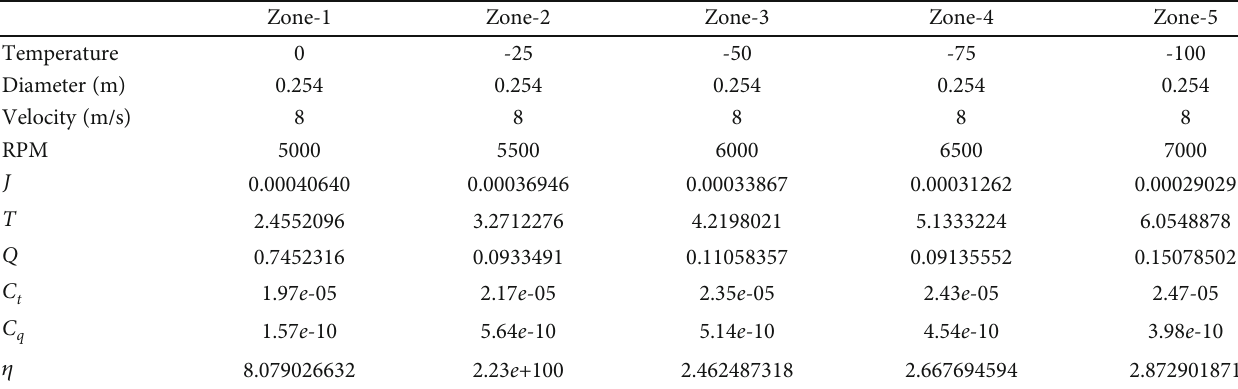
Table 6: Performance in fl uencing parameters of